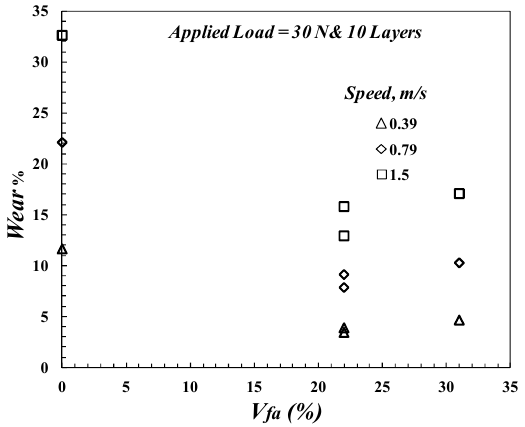
Figure 8. Wear rate as a function of average glass fiber volume of fraction, V fa . Figure 9. Wear rate as a function of applied load for different FGM specimens.